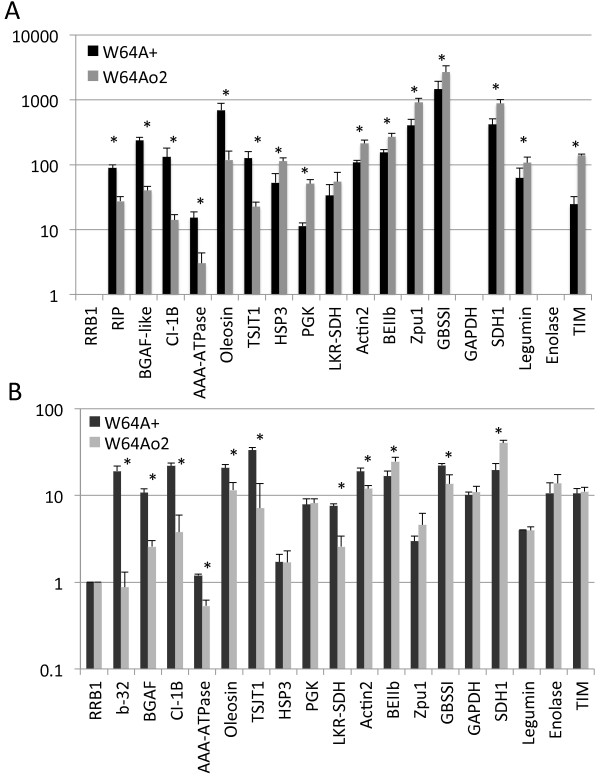
Confirmation of genes or proteins altered in W64Ao2 by qRT-PCR. Expression of the indicated genes was analyzed in 22 DAP endosperms of W64A + and W64Ao2 by GeneCalling transcript profiling (A) or qRT-PCR to confirm the difference in expression in the transcript profiling, or to measure the expression levels of genes that were differentially expressed by 2D SDS-PAGE analysis (B). All expression values are normalized relative to the expression of RRB1. Asterisks indicate significantly different expression using the two-tailed t-test at a level of p < 0.05. Note that the Y-axis is logarithmic to accommodate the wide differences in gene expression levels among the transcripts. Missing columns in A indicate that the gene was not among the genes that had a confirmed identity in the transcript profiling data.